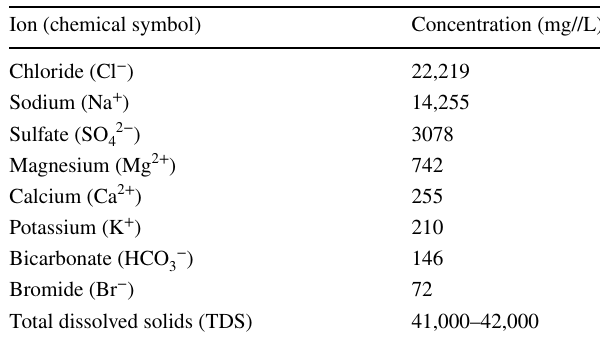
Fig. 3 Concentration polarization at the membrane surface (SOLTEQ Company: Solution Engineering 2008) Table 5 Ion composition of collected Red Sea water at Rabigh City (Greenlee et al. 2009; Lenntech